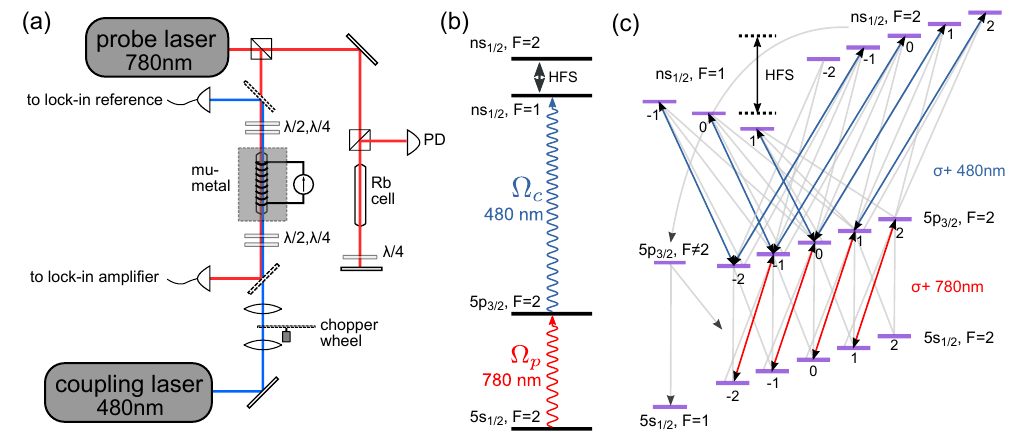
Figure 1: (a) Sketch of the experimental setup, showing the Rb vapor cell and the two diode lasers at 480nm and 780nm in a counterpropagating arrangement. The two laser beams are separated after traveling through the vapor cell by two dichroic mirrors, and detected by two photodiodes. The vapor cell is magnetically shielded by several layers of mu-metal, and surrounded by a coil with 80 windings and 11cm in length. The 480nm light is chopped by a wheel to generate a reference frequency for the lock-in detection amplifier. In addition, we perform Doppler-free saturation spectroscopy in another Rb vapor cell with the 780nm laser. (b) EIT ladder scheme with the four involved hyperfine states of the ground, intermediate and Rydberg levels (HFS: Hyperfine-Splitting), and the probe and coupling laser. (c) Magnetic Zeeman levels m of the ground state, the intermediate state and the Rydberg states involved F in the ladder type EIT scheme (note: For the Rydberg level the F , m states are only good F quantum numbers in the limit of low magnetic fields). We show the excitation paths for the combination of ( σ + , σ + ) polarization for the probe and coupling light respectively. The gray (light) lines show all considered decay paths for atomic populations in the excited states. The atomic levels 5 s , F = 1 and 5 p , F (cid:54) = 2 do not participate directly in the EIT ladder scheme, 1 / 2 3 / 2 but they are populated by decay of atomic